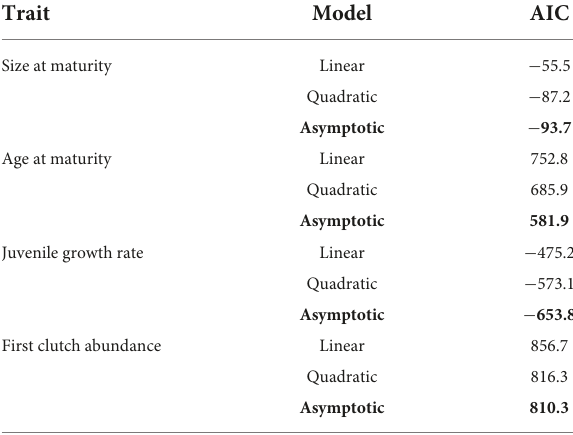
TABLE 1 Measures of goodness of fit for each of the three population-level reaction norms modeled for each life history trait. Best fit models are distinguished by their low AIC values and highlighted in bold.